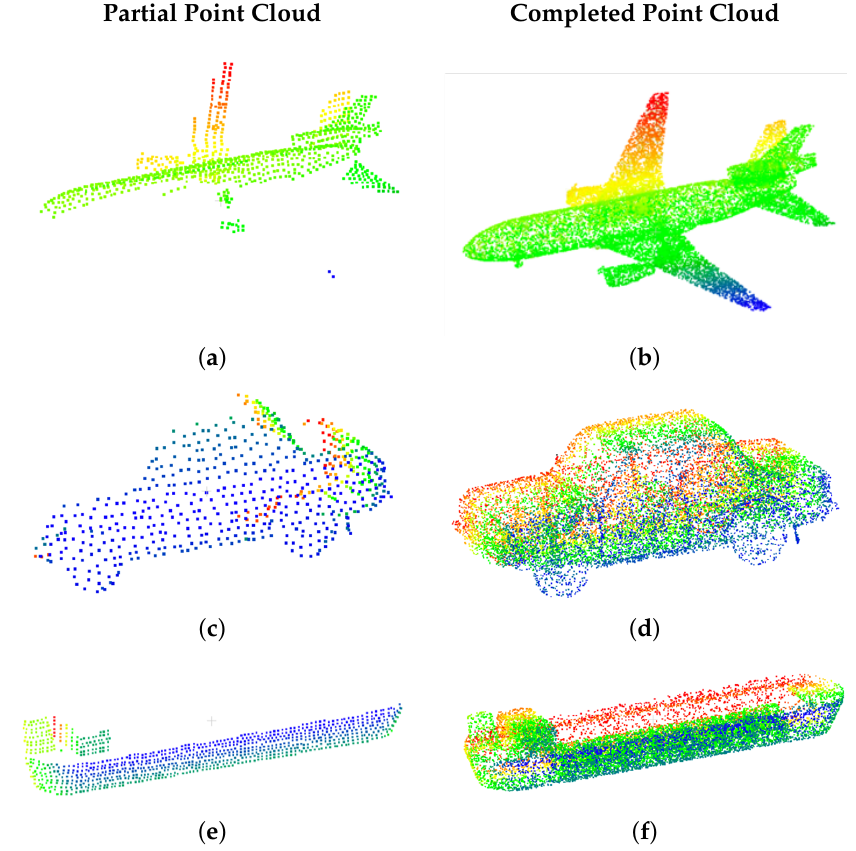
Figure 1. Examples of point clouds from the PCN dataset colored by height. The incomplete point cloud inputs are shown on the left, and the corresponding completed point clouds are shown on the right. ( a ) N = 2048, ( b ) N = 16384, ( c ) N = 2048, ( d ) N = 16384, ( e ) N = 2048, ( f ) N =